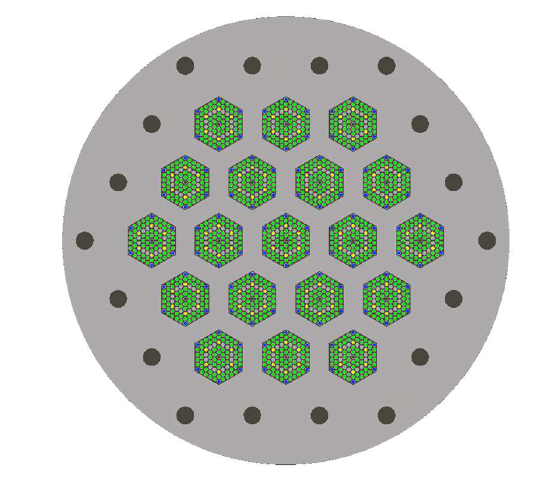
Figure 2. Full Core SmAHTR Model.